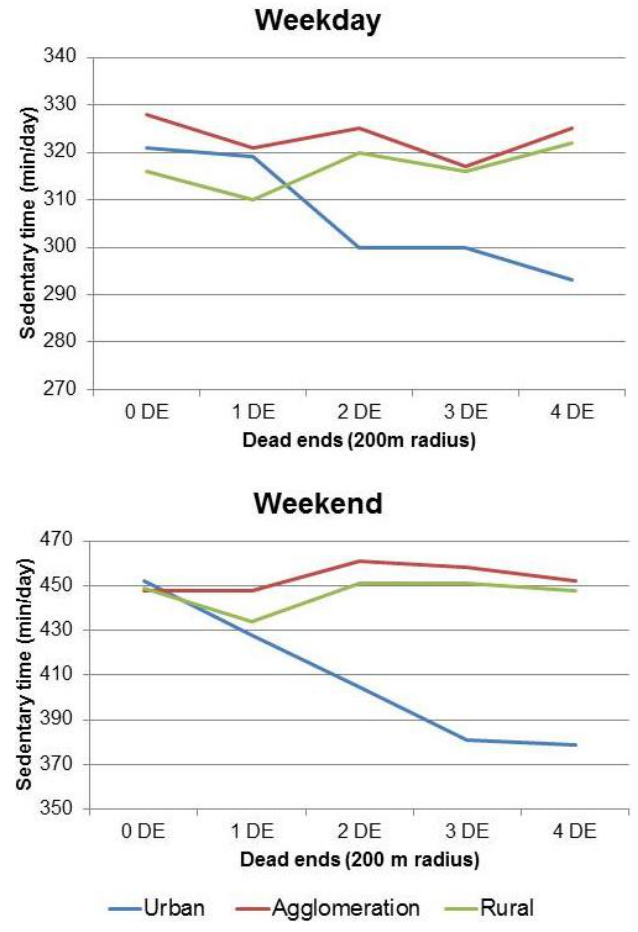
Figure 2. Association between sedentary time and dead ends by urbanicity on weekdays and the weekend. Adjusted for age, sex and accelerometer time. The graph includes only associations based on 5 children and more per category. P for interaction on weekdays: p = 0.003 and p for interaction in the weekend: p = 0.002.